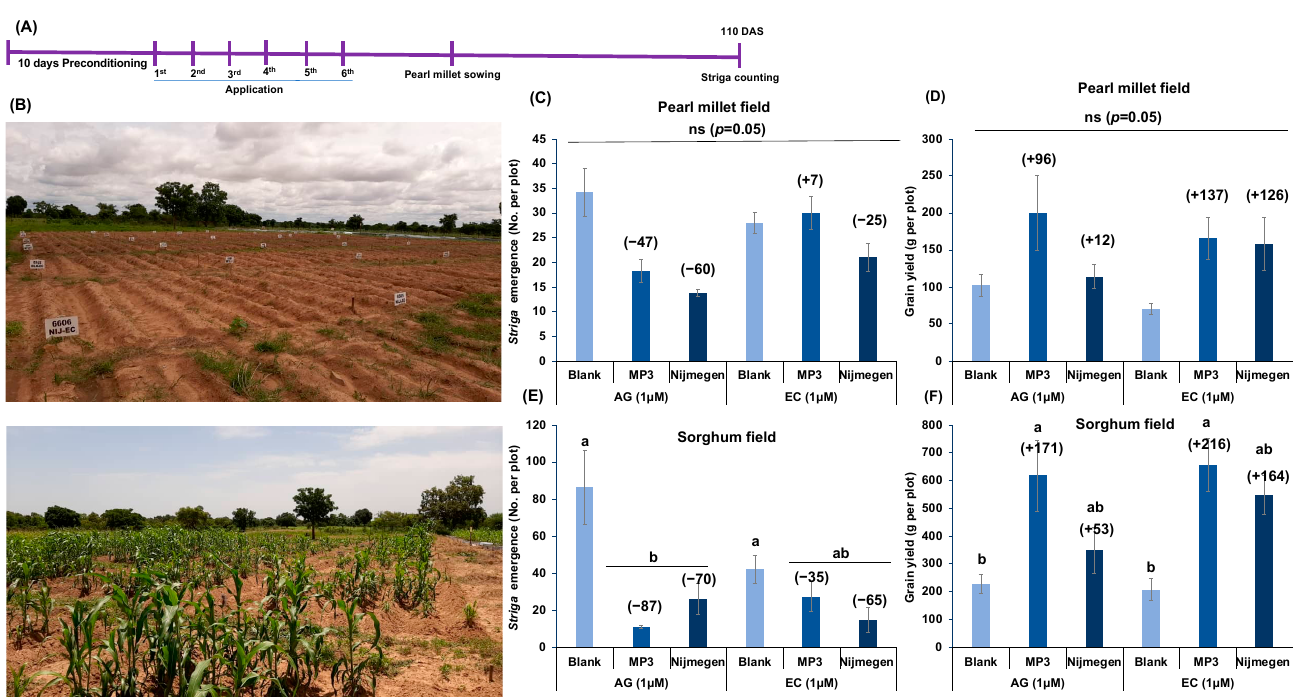
Figure 8. Effect of various formulations of SL analogs on Striga emergence and grain yield under naturally infested farmers field conditions at INERA, Burkina Faso. ( A ) Scheme of the experiment conducted for Striga emergence under farmers field conditions during 2020. ( B ) View of the Striga infested farmers field at Fada N’gourma, Burkina Faso. ( C ) Average number of Striga emergence in the pearl millet field in response to formulated MP3 and Nijmegen application. ( D ) Average grain yield per plot from the pearl millet field in response to formulated MP3 and Nijmegen application. ( E ) Average number of Striga emergence in the sorghum field in response to formulated MP3 and